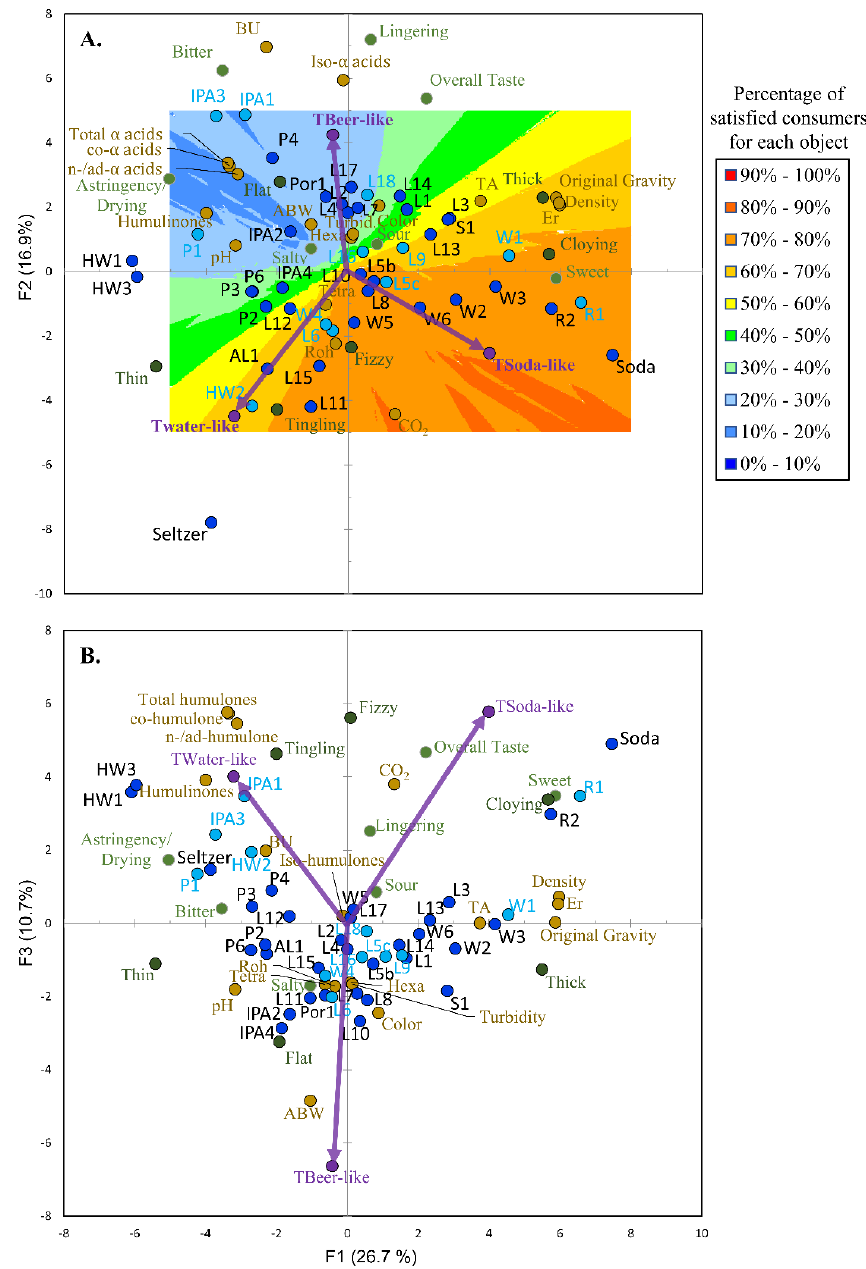
Figure 3. Principle component analysis biplots of the beer-like, soda-like, water/flavored water-like ratings (purple circles/arrows, Table 1) for the trained panel along with the statistically different taste/mouthfeel attributes (light green circles (DA terms) and dark green circles (CATA terms)) amongst the different products (light- and dark-blue circles, Table 1) and non-volatile factors (light brown circles). The samples highlighted by the dark blue circles were evaluated only by the trained panel, whereas the samples highlighted by the twelve light blue circles were also evaluated by consumer analysis. PC1 and PC2 ( A ) described 43.6% of the variation in the data, while PC1 and PC3 ( B ) accounted for an additional 10.7%. External preference mapping (using F-ratios to find the best vector model, p < 0.05, contour plot threshold % = 100) was performed as described in Section 3.2. The consumers were least satisfied with the products in the dark blue region, whereas consumers were more satisfied with the products in the dark red/ orange region.